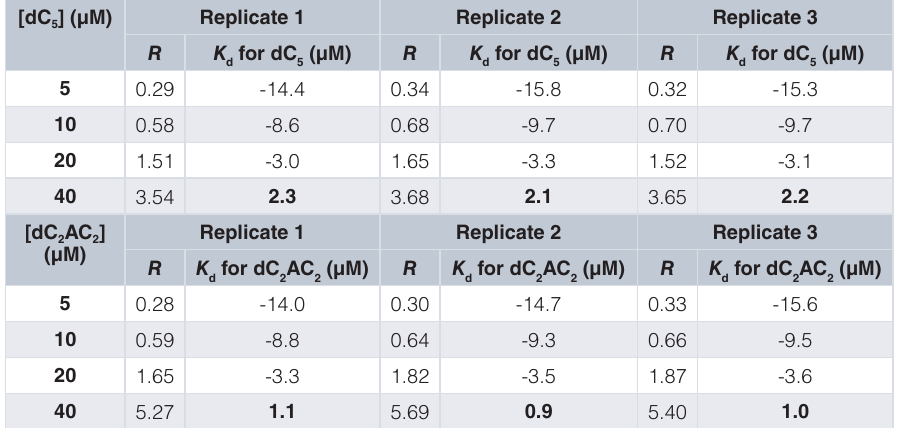
Table 6. The total ion abundance ratio ( R ) and dissociation constant ( K [deoxyoligonucleotide]. Data used for calculations was from Table 5. [dC ] 5